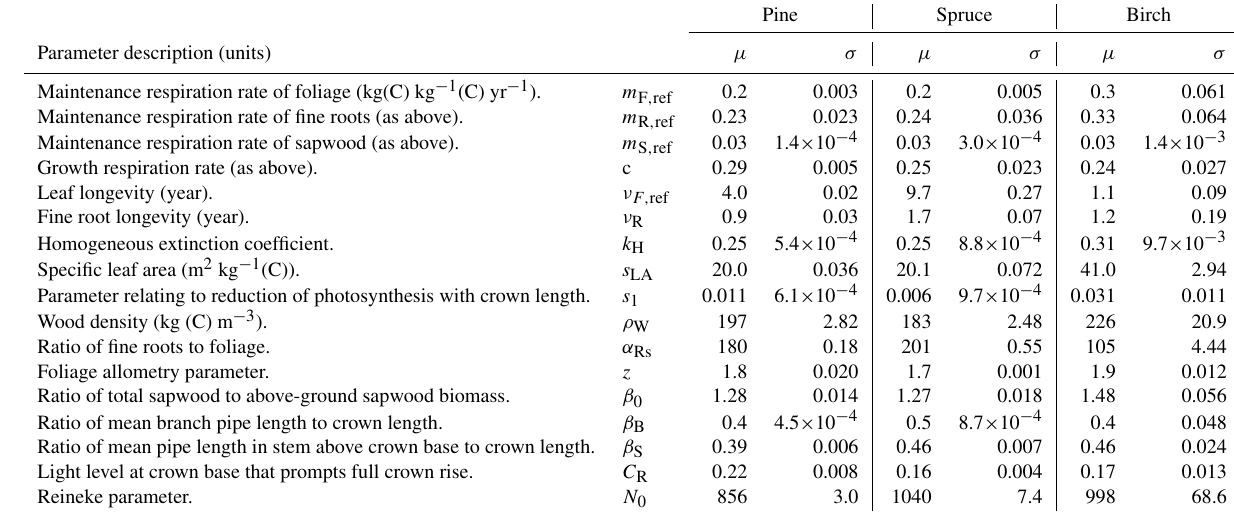
Pine Spruce Birch